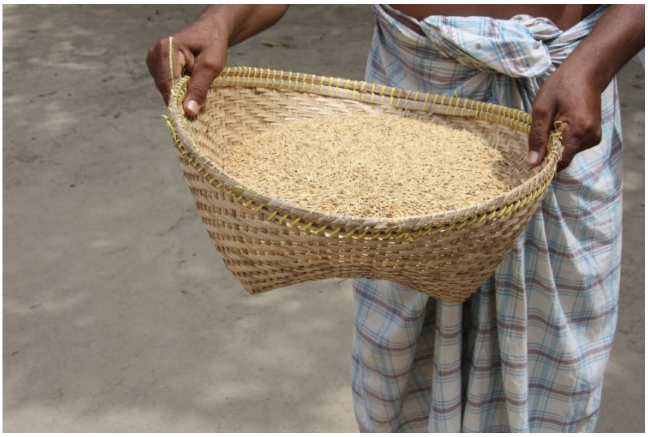
Figure 3. Baskets made from woven reeds and bamboo filled with rice to assess the rice losses due to rodents. Weight losses of the rice in the baskets could be influenced by potential moisture